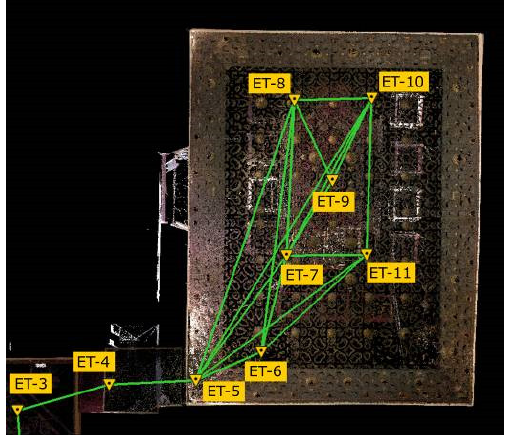
Figure 10. Detail of the scanner station positions within the mezzanine room.